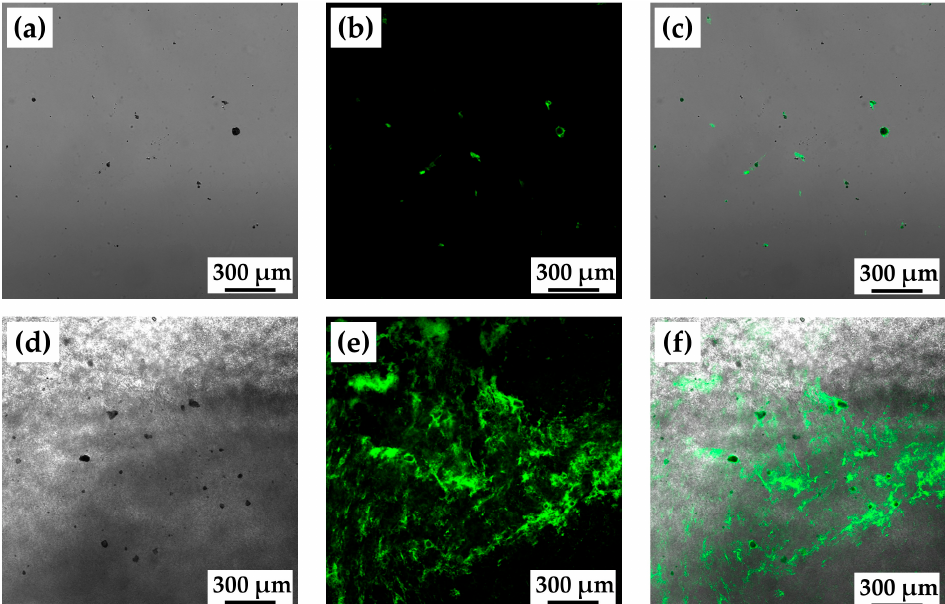
Figure 6. ( a ) The bright field, ( b ) fluorescence, and ( c ) overlay confocal laser microscopy images of nHAp mixed with fluorescein isothiocyanate (FITC)-labeled type I collagen; ( d ) the bright field, ( e ) fluorescence and ( f ) overlay confocal laser microscopy images of cHLA/cAG/nHAp/FITC-labeled type I collagen. Note: FITC-labeled type I collagen tended to highly bind to nHAp particles.